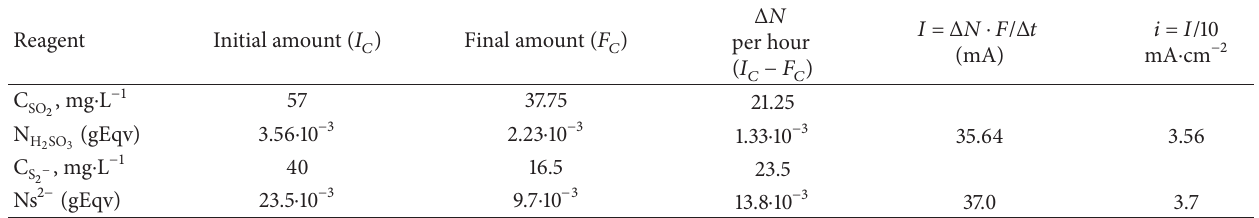
Table 1: Data of initial and final concentration of S 2− and SO